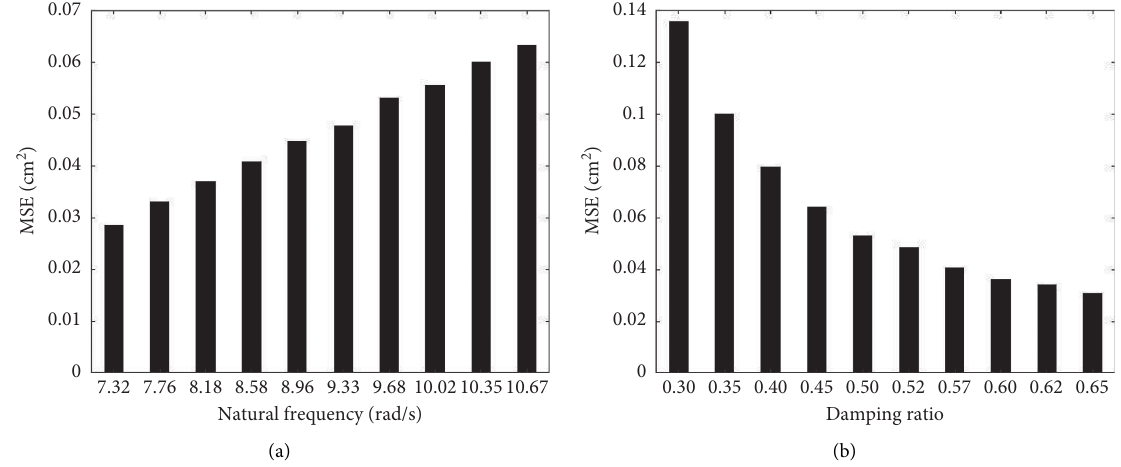
Figure 7: The pavement profile error for different values of fundamental frequency and damping ratio. (a) Fundamental frequency variation ( ζ � 0 . 5). (b) Damping ratio variation ( ω n �